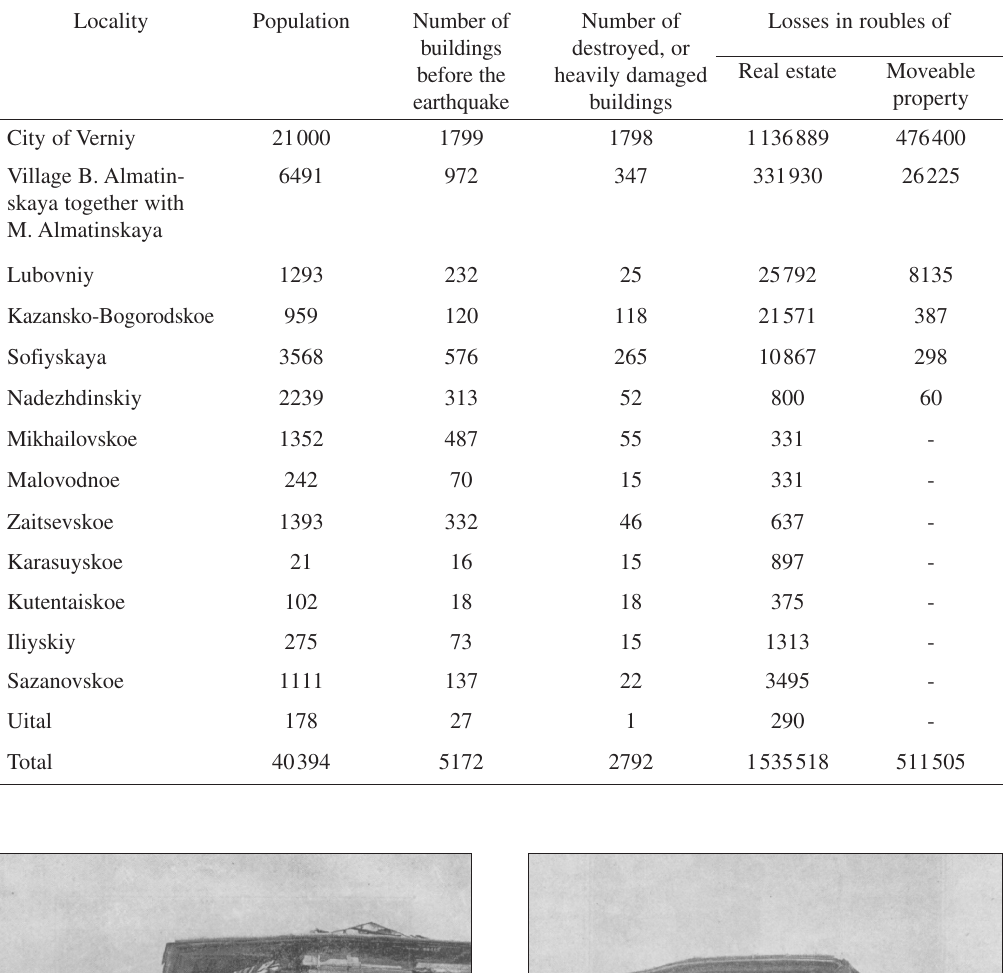
Table III. Summary table of damage and losses report of 1887, Verniy earthquake compiled by Mushketov (1890).